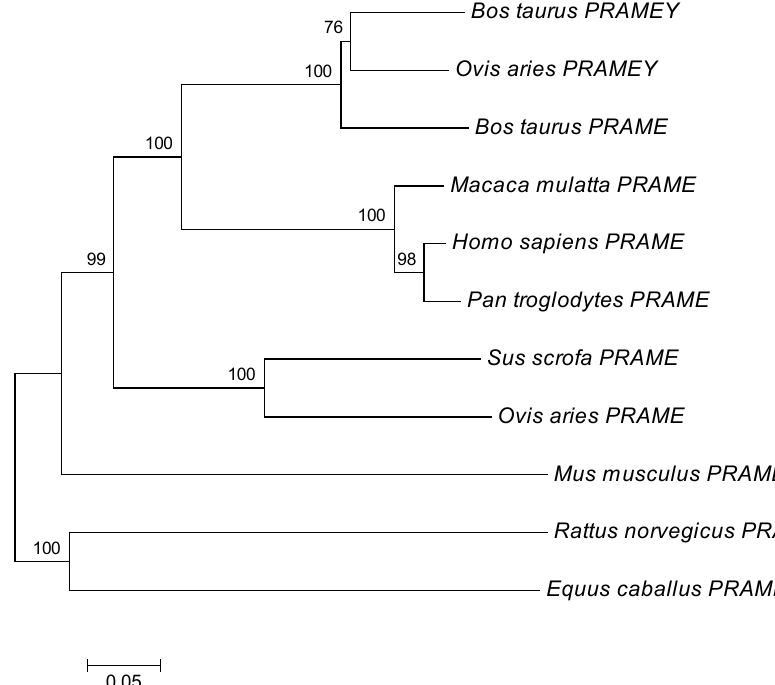
Figure 2. Neighbor-joining tree of PRAMEY / PRAME proteins. The GenBank accession numbers of PRAMEY protein are Bos taurus , ADP21954, and PRAME protein are Bos taurus , NP_001232882; Macaca mulatta , AFJ71405; Homo sapiens , CAG30435; Pan troglodytes , NP_001267447; Sus scrofa , XP_020953254; Ovis aries , XP_027831889; Mus musculus , NP_001108549; Rattus norvegicus , XP_001055257.2; Equus caballus , XP_023502450. The numbers on the branches represent 1000 bootstrap values.